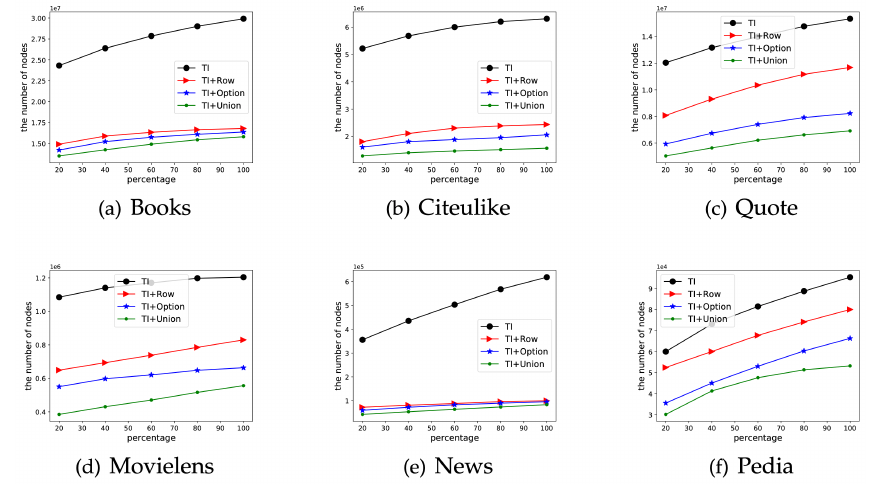
Figure 5. Evaluation of the index